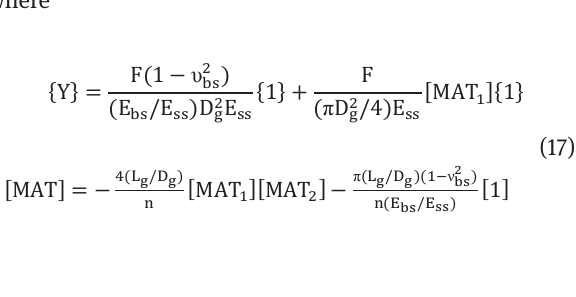
Table 1: Validation of